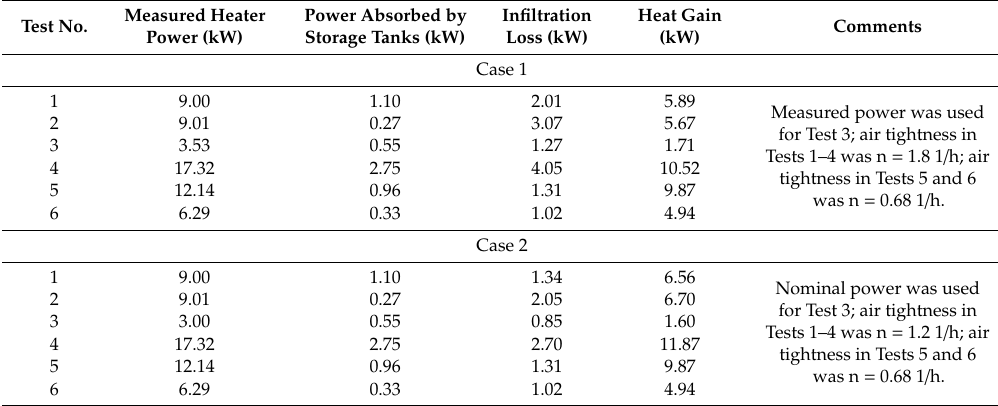
Table 2. Heat input during dynamic heating tests.